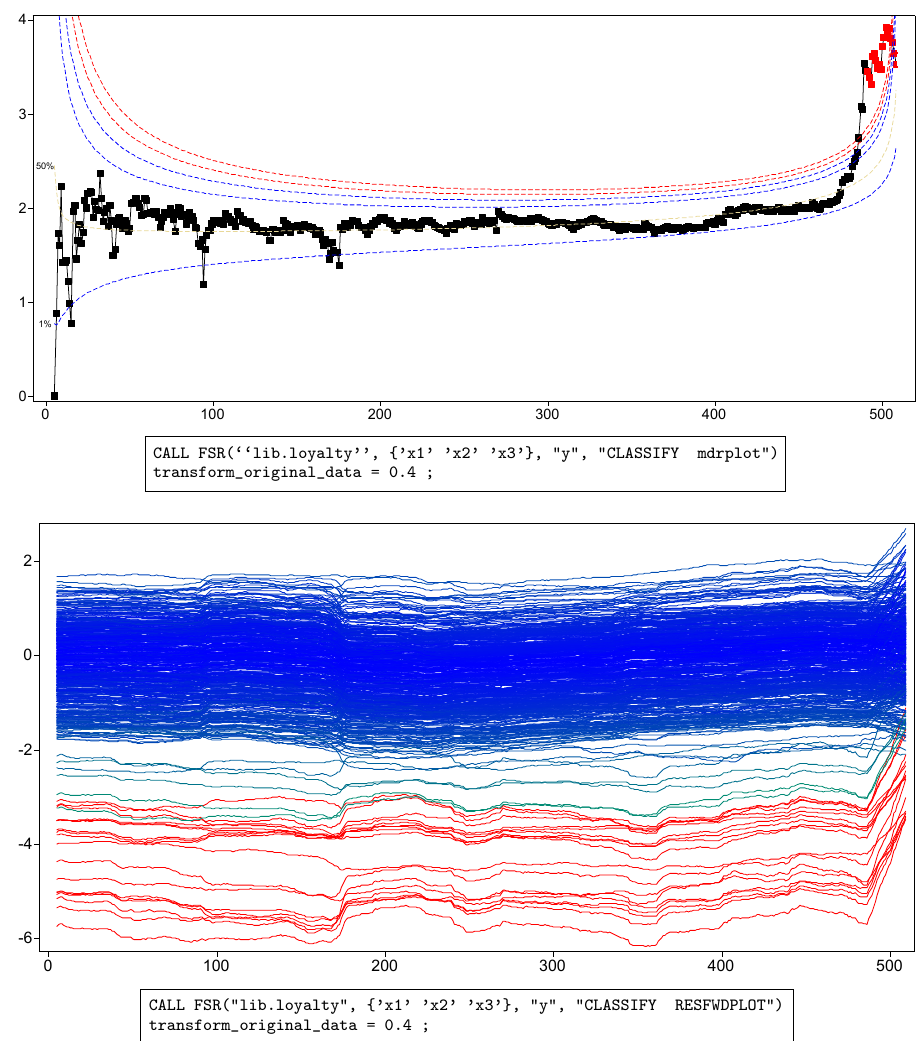
Figure 2. Loyalty card data: monitoring plots for the transformed data with λ = 0.4. The top panel shows the absolute values of minimum deletion residuals among observations not in the subset; the last part of the curve, corresponding to the 18 identified outliers, is automatically highlighted in red (in the online .pdf version). The bottom panel shows the scaled residuals, with the trajectories corresponding to the 18 detected outliers automatically represented in red (in the online .pdf version). The box under each panel contains the SAS code used to generate the plot.